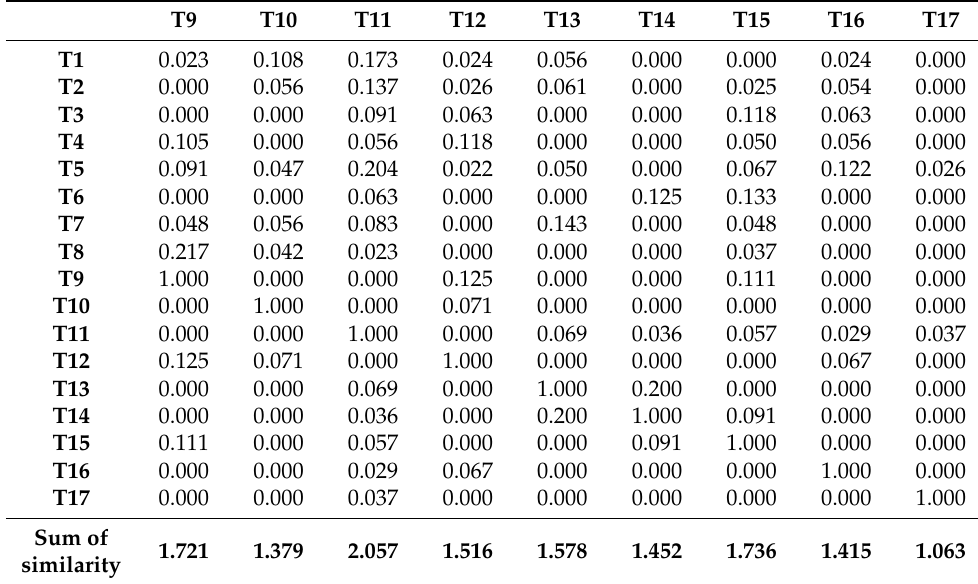
Table 4. Inter-attribute Matrix